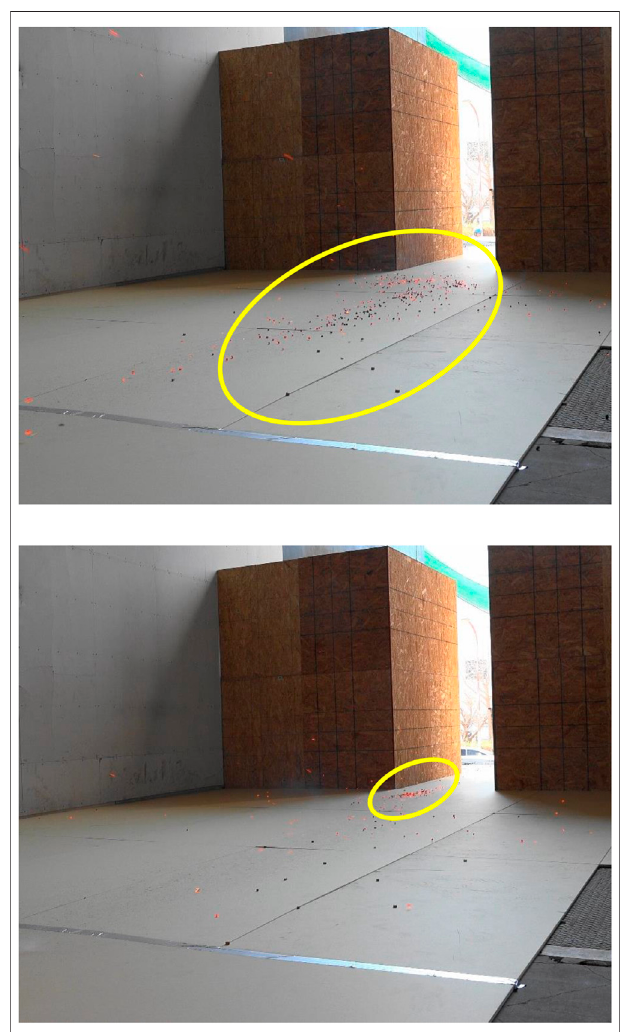
FIGURE 6 | Firebrand behavior under SD (cid:2) 1 m and 8 m s − 1 .